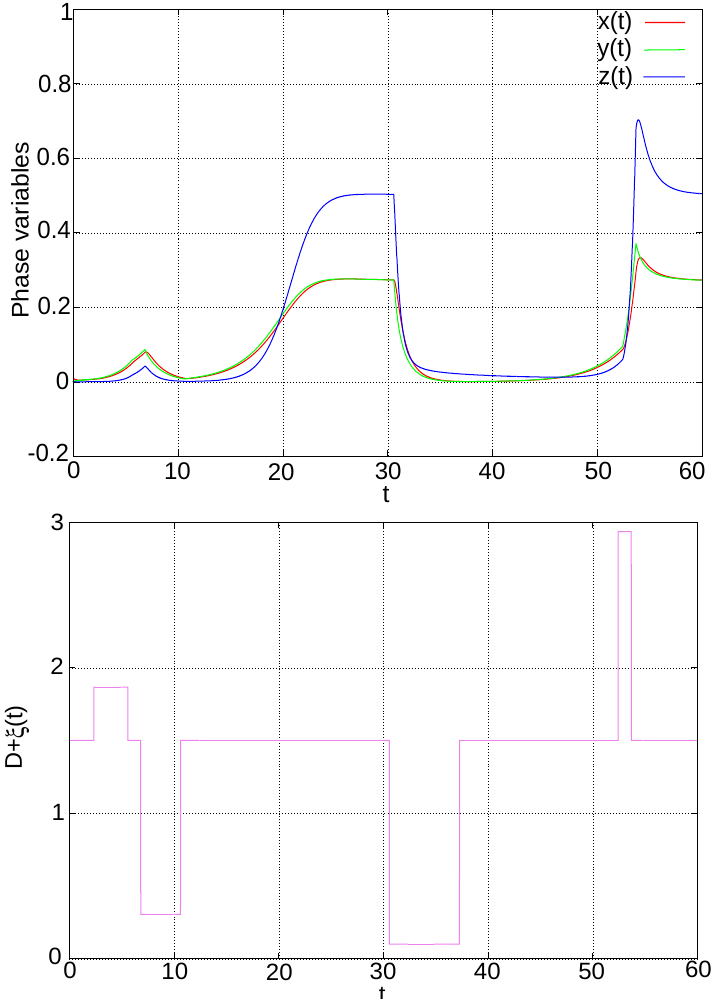
Figure 1. Example of numerical study of zero equilibrium point stability: K ( s ) = s − β / Γ ( 1 − β ) , β = 0.9, µ = 3.37, p = r = γ = 1, T W = T E = 5, ν = 2, σ =